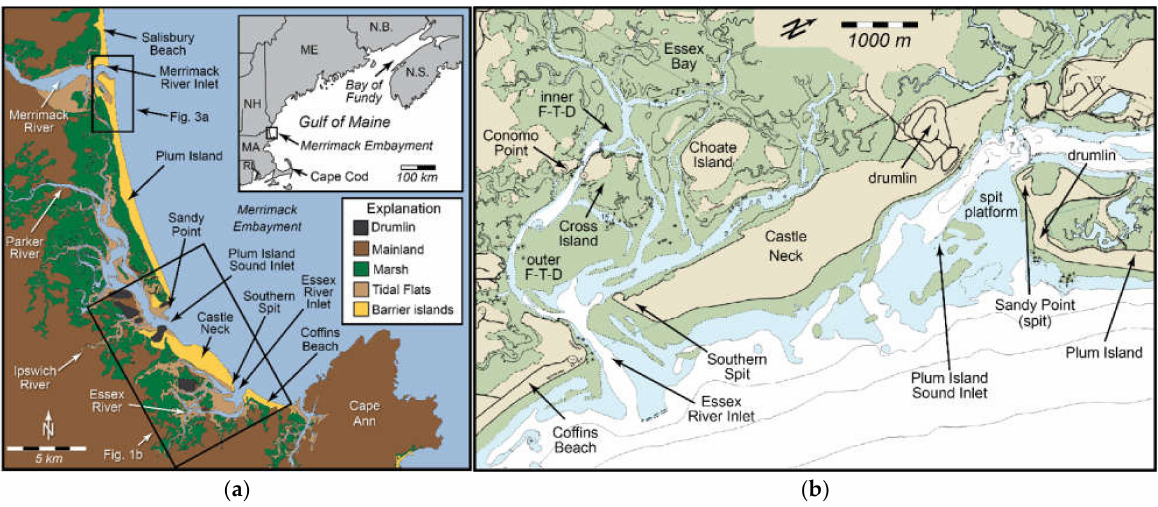
Figure 1. Study site: ( a ) physical setting of the barrier-island systems of the Merrimack Embayment (northern Massachusetts), western Gulf of Maine. Modified from [46]; ( b ) NOAA coastal chart 13274 (2011) of southern Plum Island and Castle Neck and associated tidal inlets. Many of the islands within the marsh are composed of one or several amalgamated drumlins. Plum Island Sound (PIS) and Essex River Inlets are anchored by drumlins and bedrock outcrops. Essex Bay contains an inner and outer flood-tidal